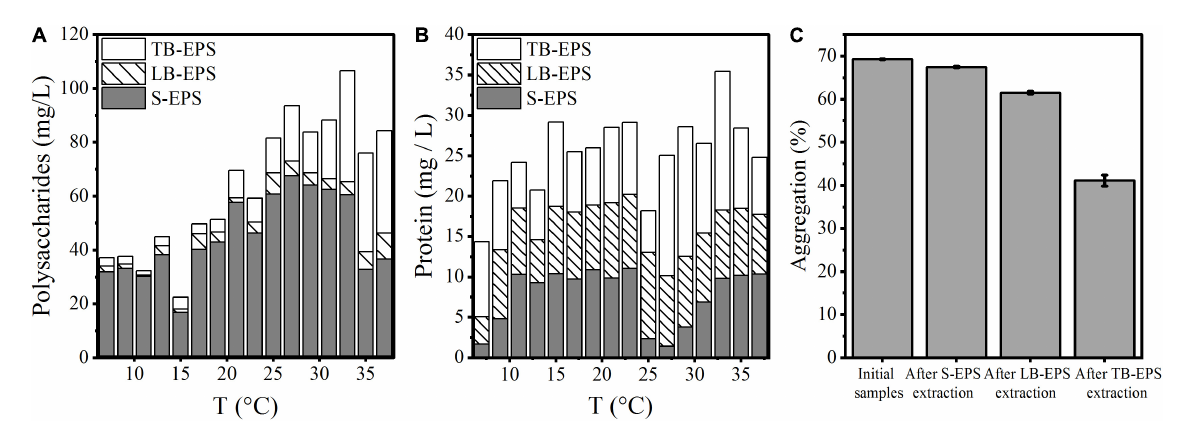
FIGURE2 Variations of composition in EPS matrix with temperature and the relationship between aggregation and EPS fractions for A. flos-aquae . (A) Variation of polysaccharides with temperature; (B) Variation of protein with temperature; (C) Variation of aggregation with removed EPS fraction in